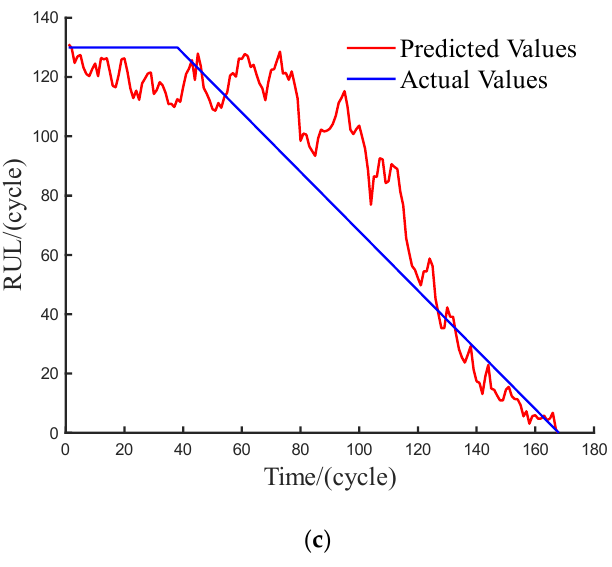
Figure 15. ( a ) RUL prediction results for engine units #52 of FD001; ( b ) RUL prediction results for engine units #81 of FD001; ( c ) RUL prediction results for engine units #100 of FD001.